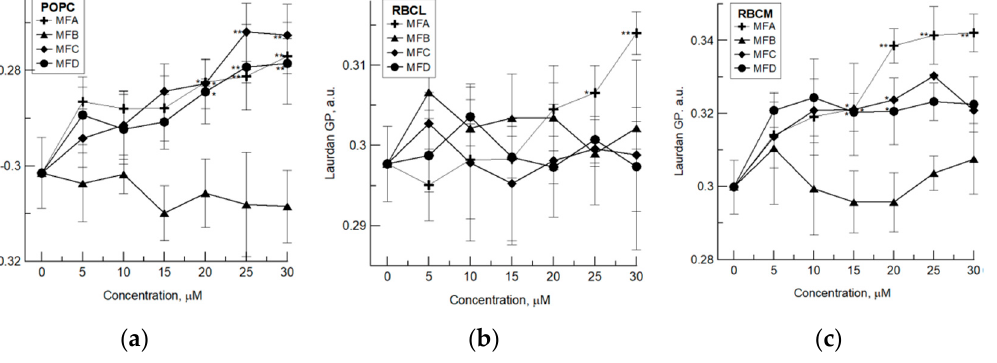
Figure 3. The changes in generalized polarization (GP) of Laurdan probe observed under the influence of MFA, MFB, MFC, and MFD compounds in: ( a ) 1-palmitoyl-2-oleoyl-glycero-3-phosphocholine (POPC) liposomes; ( b ) liposomes formed from lipids extracted from erythrocyte membrane (RBCL); ( c ) red blood cell membrane (RBCM). The experiment was carried out in three replicates, the results were presented as mean ± standard deviation. Statistically significant differences between modified and control membranes are marked: * α = 0.05; ** α = 0.01.